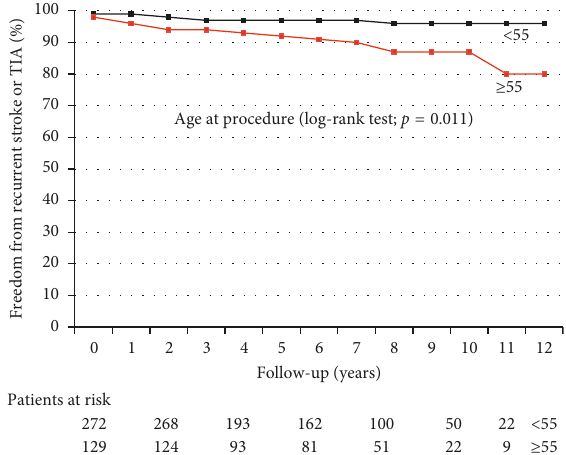
Figure 4: Kaplan–Meier plot showing freedom from recurrent stroke and/or TIA over a 10-year time frame in patients with RoPE score < 7 versus those with RoPE score ≥ 7 at the time of the procedure. p � 0 . 027 by log-rank